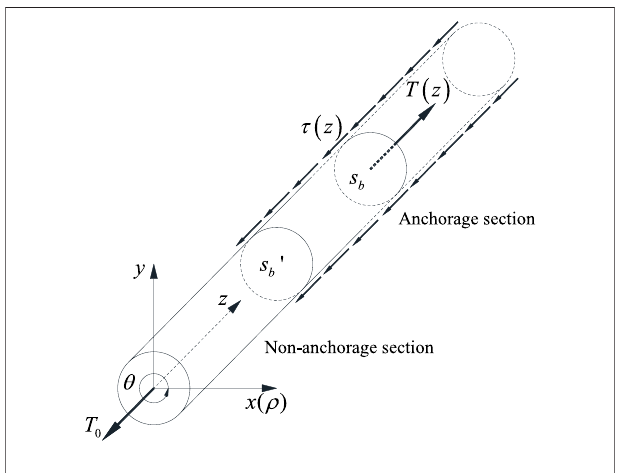
FIGURE 2 | Bolt stress diagram.